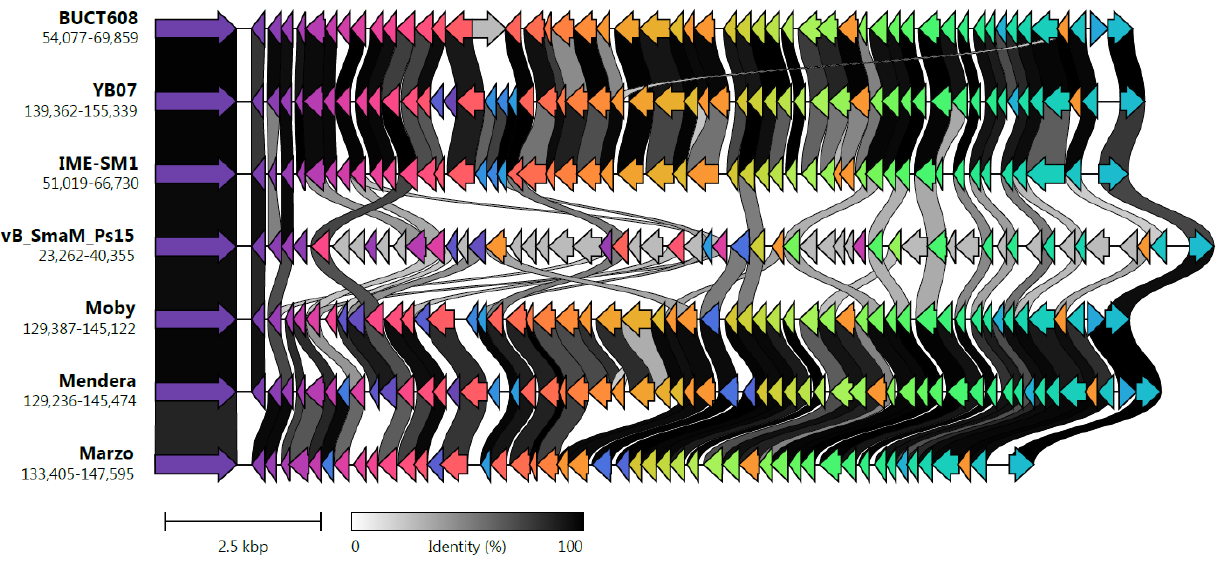
Figure 9. Detailed pairwise comparison of the long cluster of genes encoded in the reverse strand of Menderavirus . The view is extended to the first conserved genes in the positive strand at each side of the region. The strains are ordered based on Figure 8C. Gene links are shaded based on identity (minimum 30%). Image generated with Clinker v0.0.21 [72].